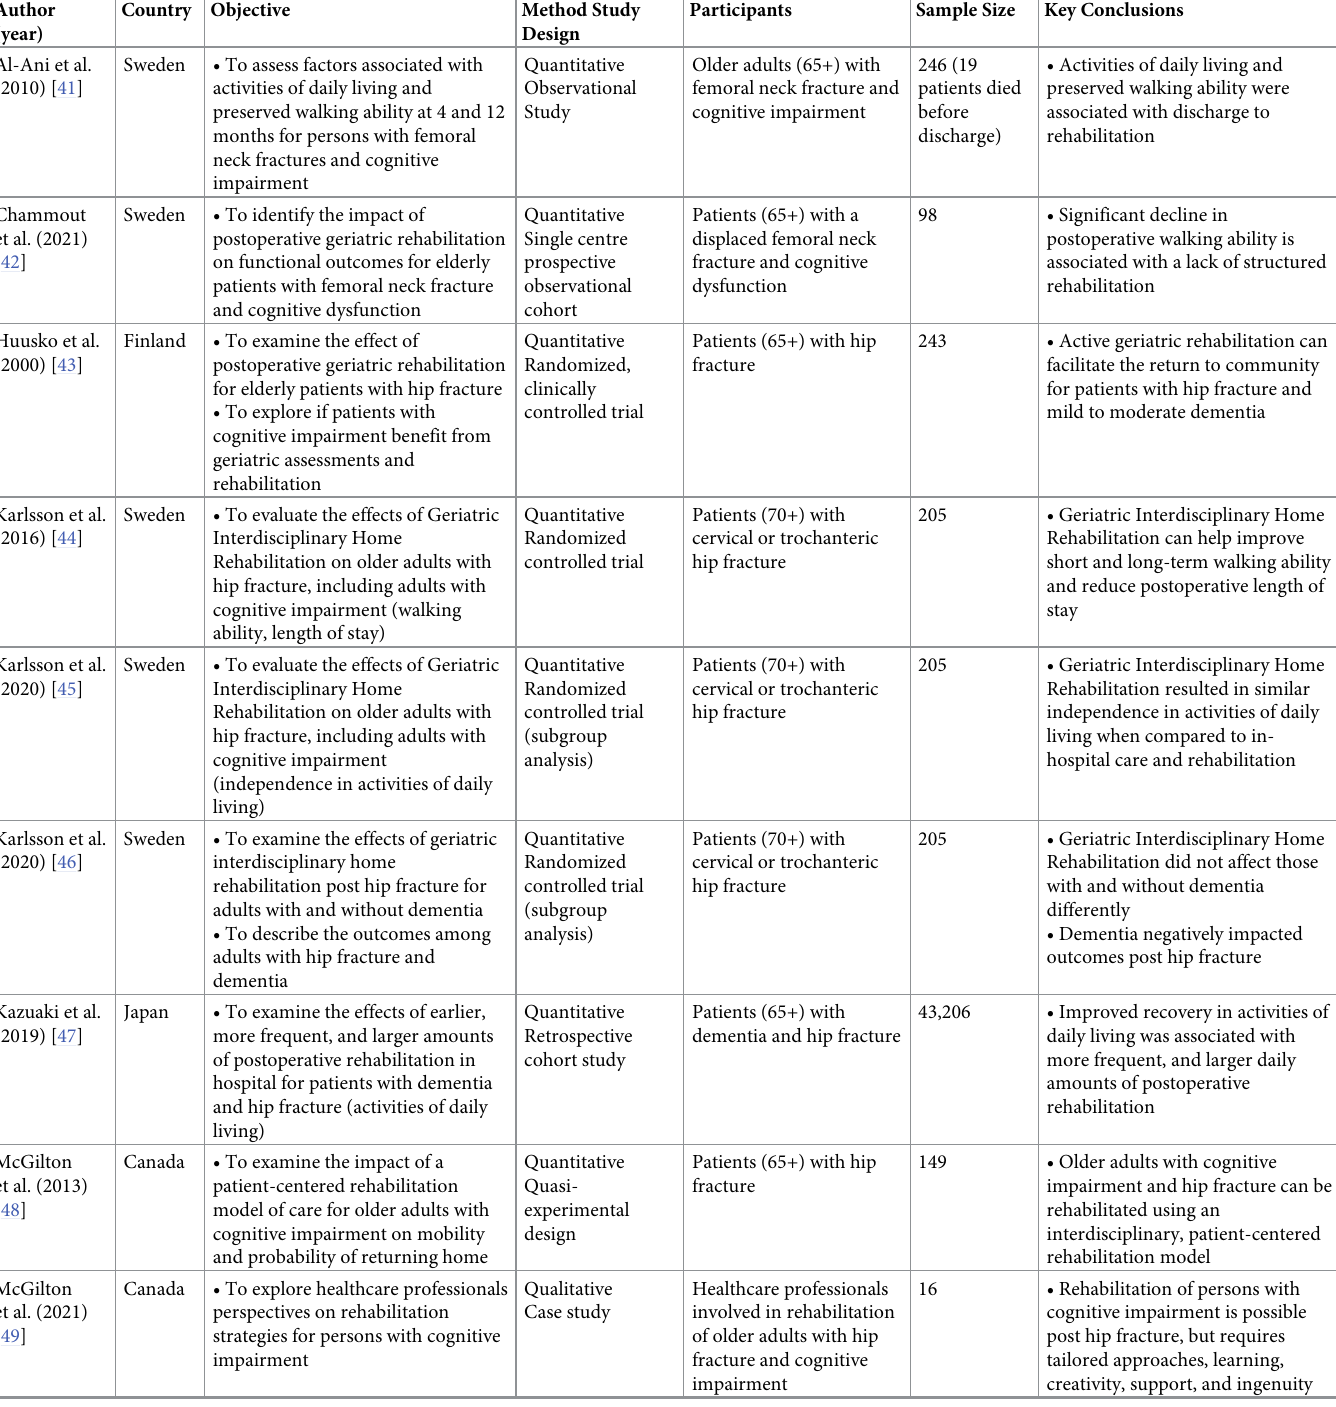
Table 1. Characteristics of included articles (n =